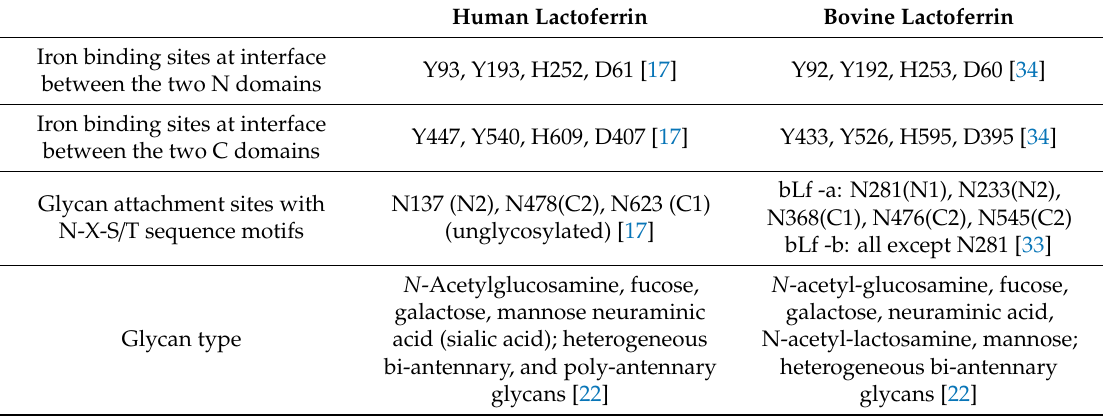
Table 1. Features of human and bovine lactoferrin .